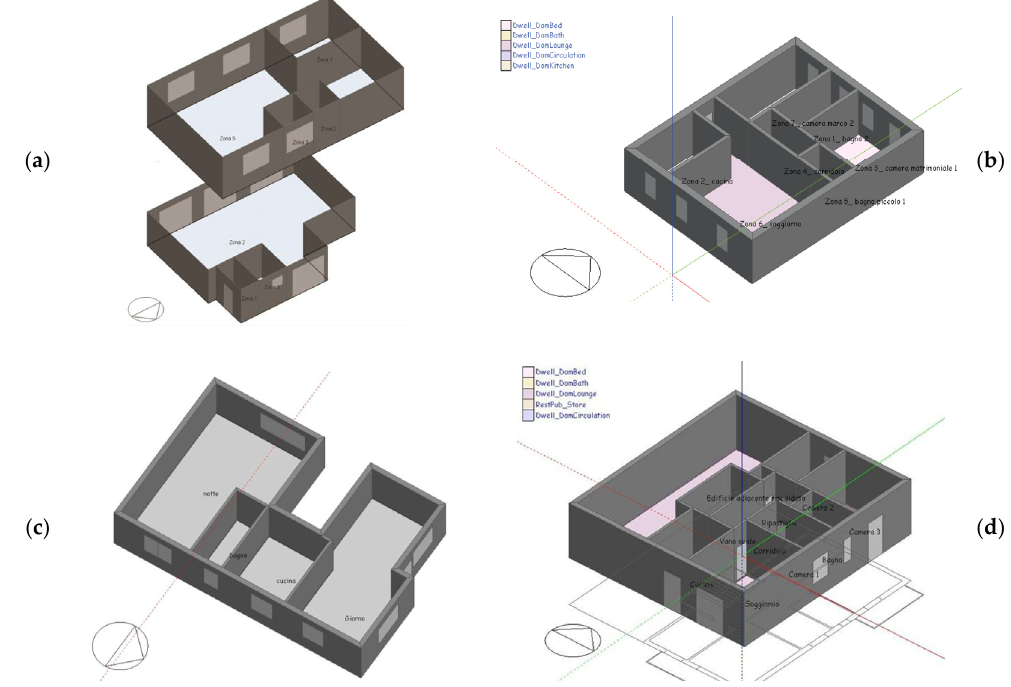
Figure 7. Examples of buildings assessed via building energy simulation and ANNs, with ( a ), ( b ), ( c ) and ( d ) respectively referring to building codes in Table 11.